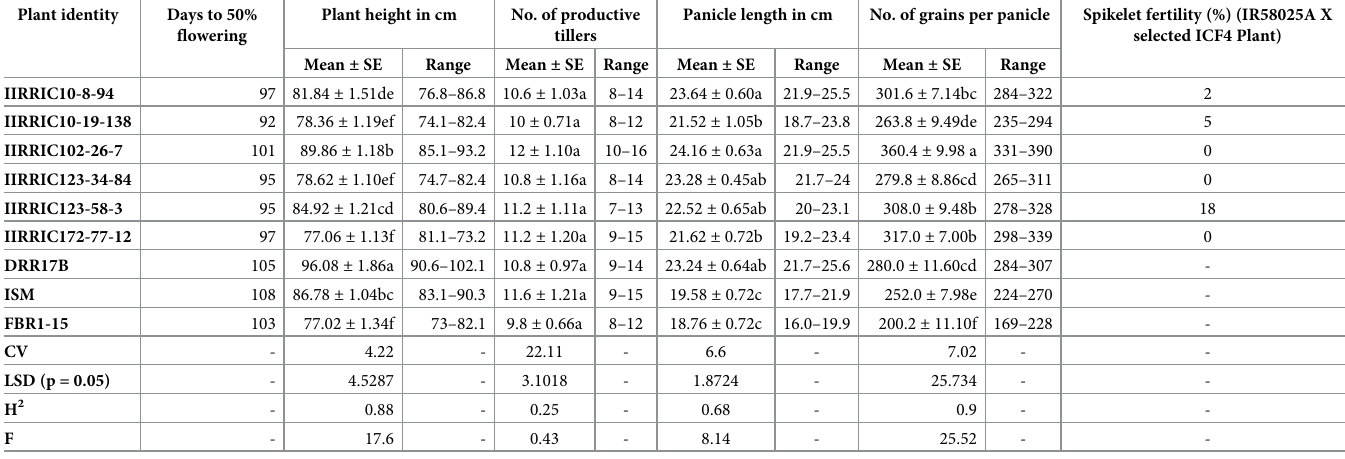
Table 4. Agro-morphological features of selected backcross derived lines of DRR17B possessing Xa21 + Xa33 . Plant identity Days to 50%